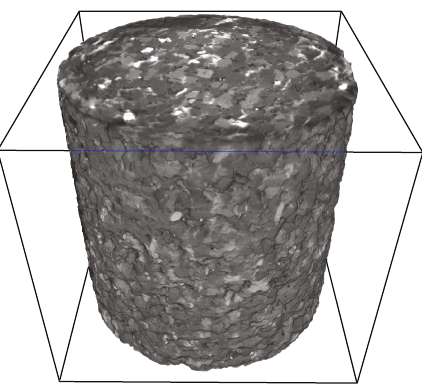
Figure 1: The CT scanning image of the core